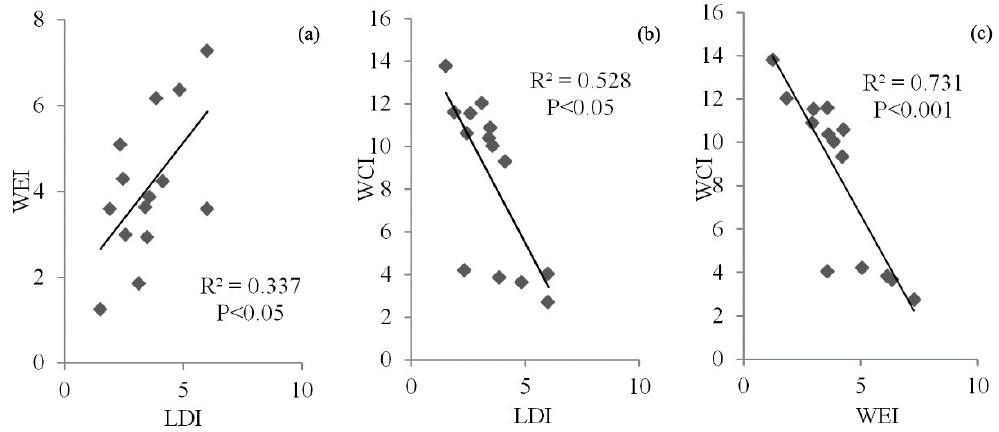
Figure 8. Linear regressions between the wetland condition index (WCI) and the values of the sub-indices in moderately urbanized regions (Qinglong and Qilin). Panel ( a ) shows the relationship between the LDI and WEI ( n = 14). Panels ( b , c ) show the relationships between the WCI and LDI and the WCI and WEI ( n = 14), respectively.